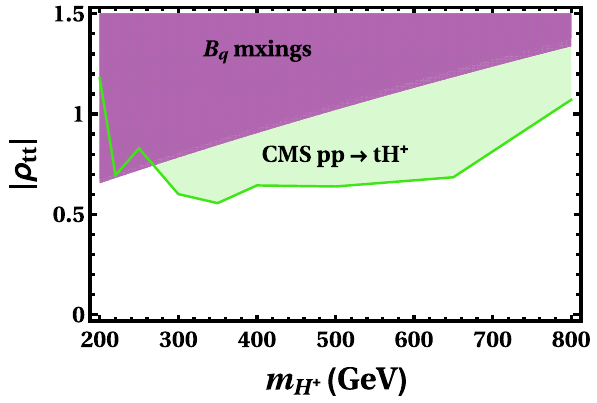
Fig. 5 The purple and green shaded regions are excluded by B q mix- ings and pp → ¯ tH + search [66] respectively